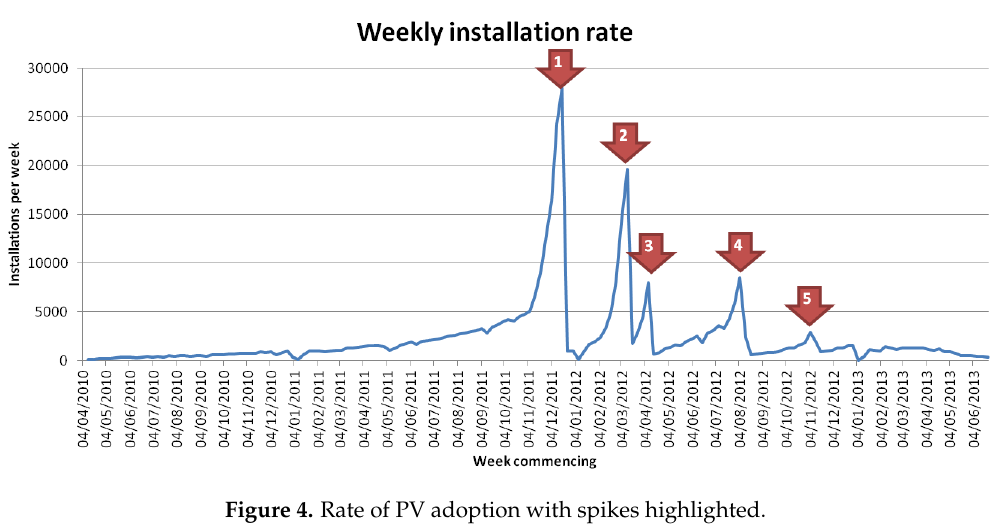
Figure 4. Rate of PV adoption with spikes highlighted. Table 1. Data of the PV adoption rate